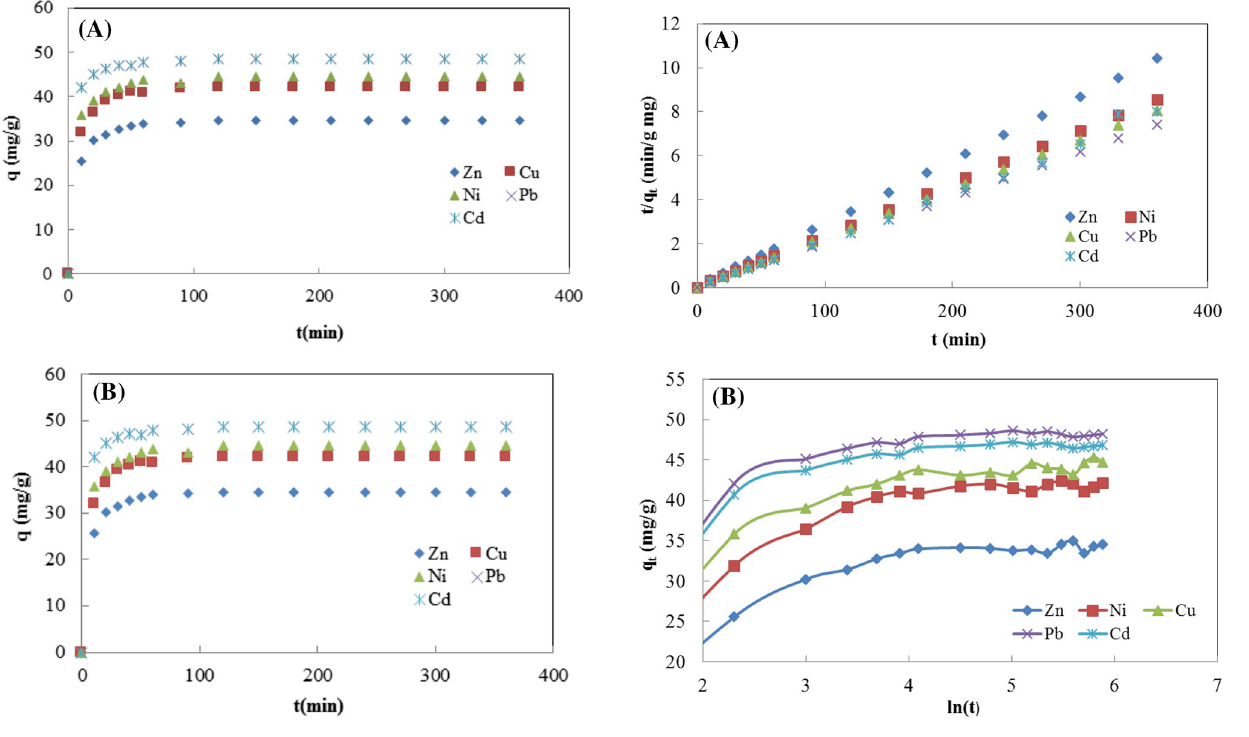
Fig. 7 a Plots of pseudo-second-order kinetics of Zn(II), Ni(II), Cu(II) and Pb(II) by Posidonia oceanica and b plots of Elovich